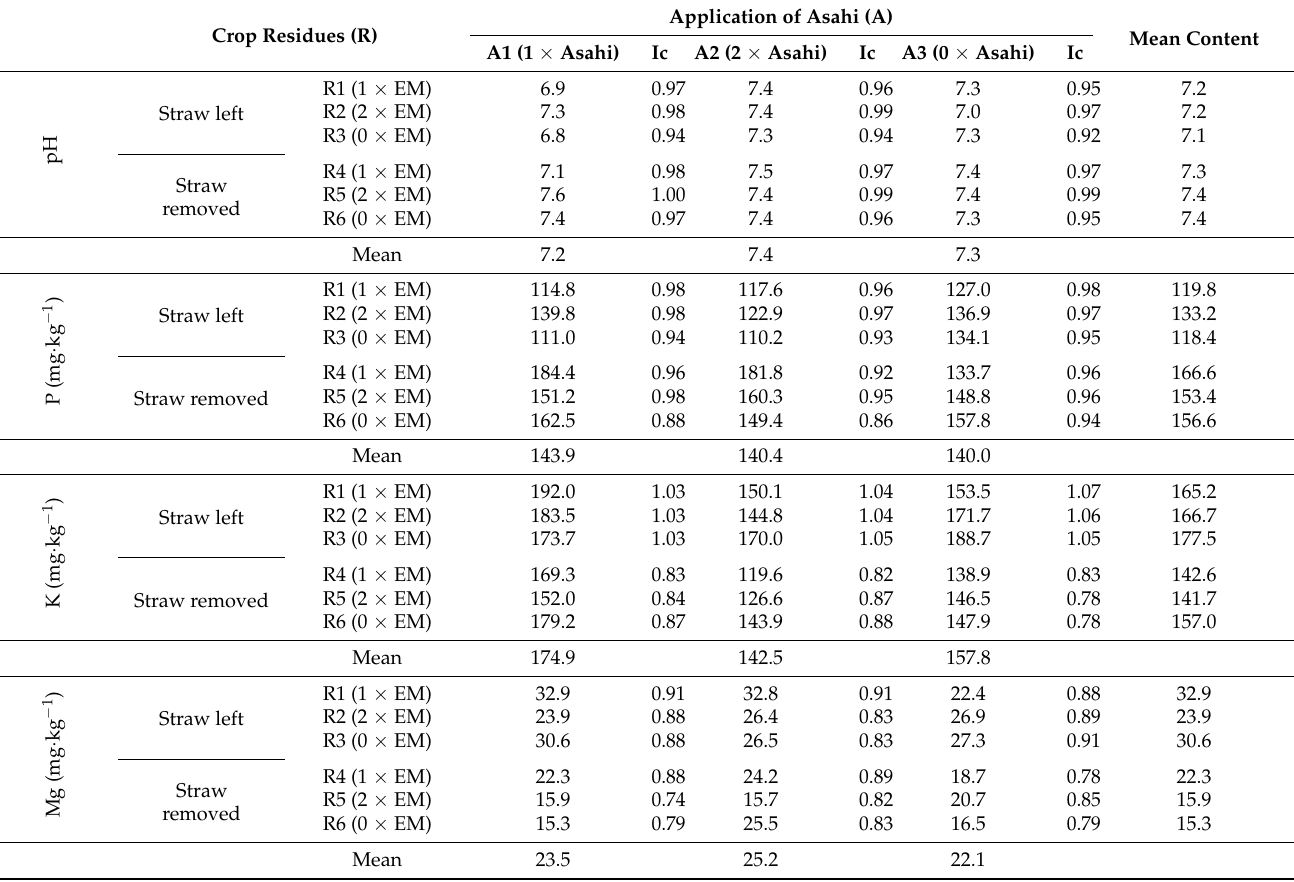
Table 5. Soil phosphorus (P), potassium (K), and magnesium (Mg) (mg · kg − 1 ) content, and pH of the soil, depending on the management of plant residues with the addition of the biopreparation EM (R factor) and the application of the biostimulant Asahi (A factor) in spring barley cultivation. Crop Residues